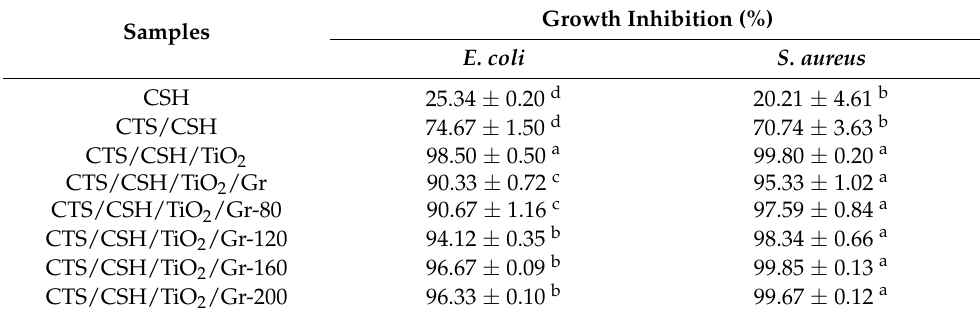
Table 6. Effects of the CTS/CSH, CTS/CSH/TiO 2 , and CTS/CSH/TiO 2 /Gr composite films (TiO 2 :Gr = 6:4) on the growth inhibition rates (%) of E. coli and S. aureus